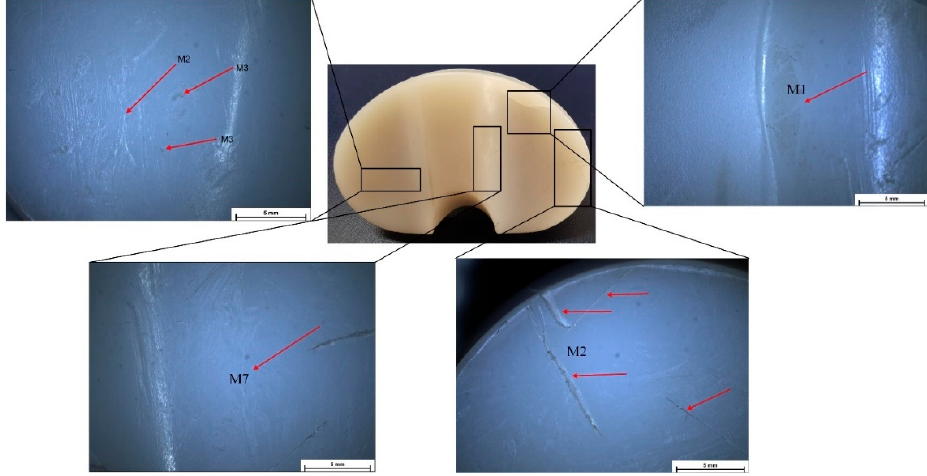
Figure 6. Stereomicroscopy images obtained in the case of IT3 sample.